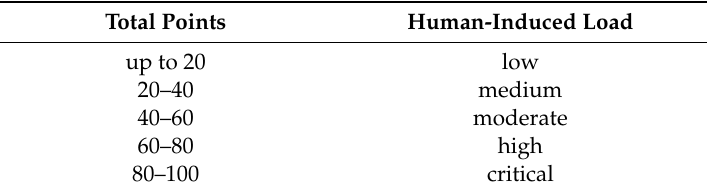
Table 4. Summary scale of the total human-induced load calculation.